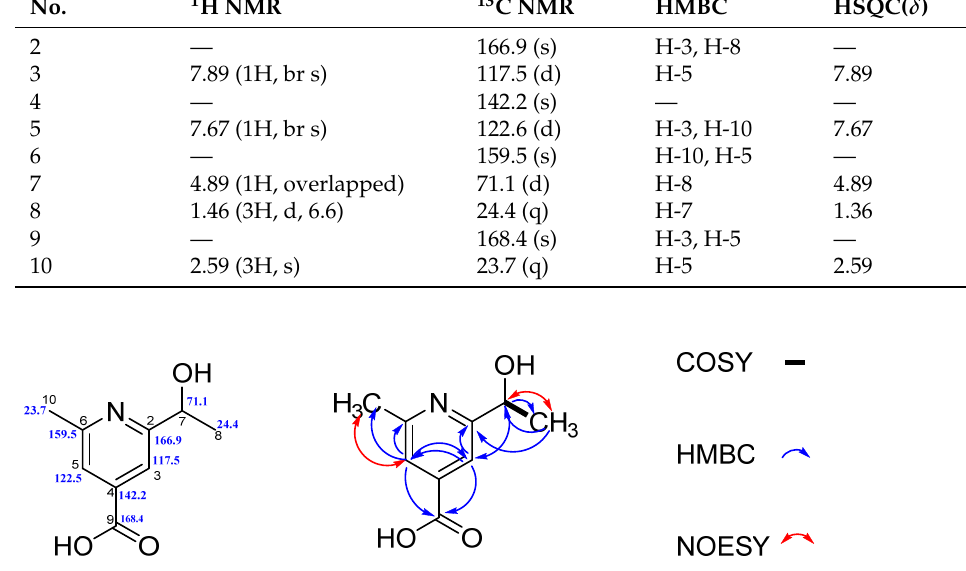
Figure 5. Signal assignment of compound 7 via 13 C and 2D NMR.